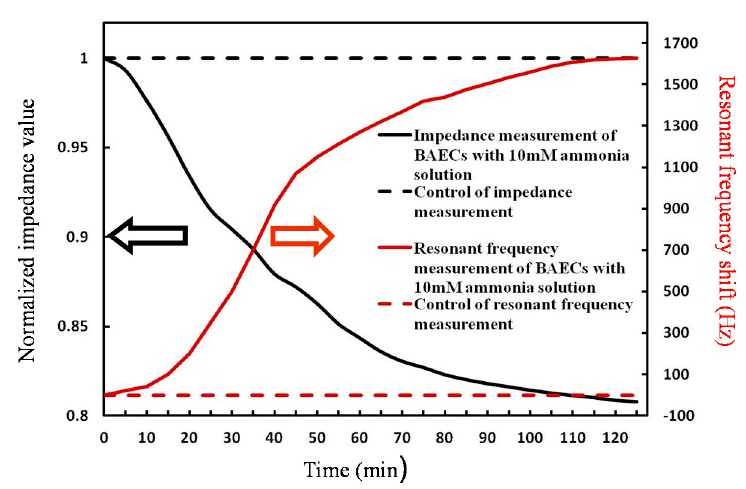
Figure 9. Simultaneous impedance measurements and resonant frequency measurements for testing the BAECs with the cells seeding density: 3 × 104 cells/cm 2 with 10 mmol/L of